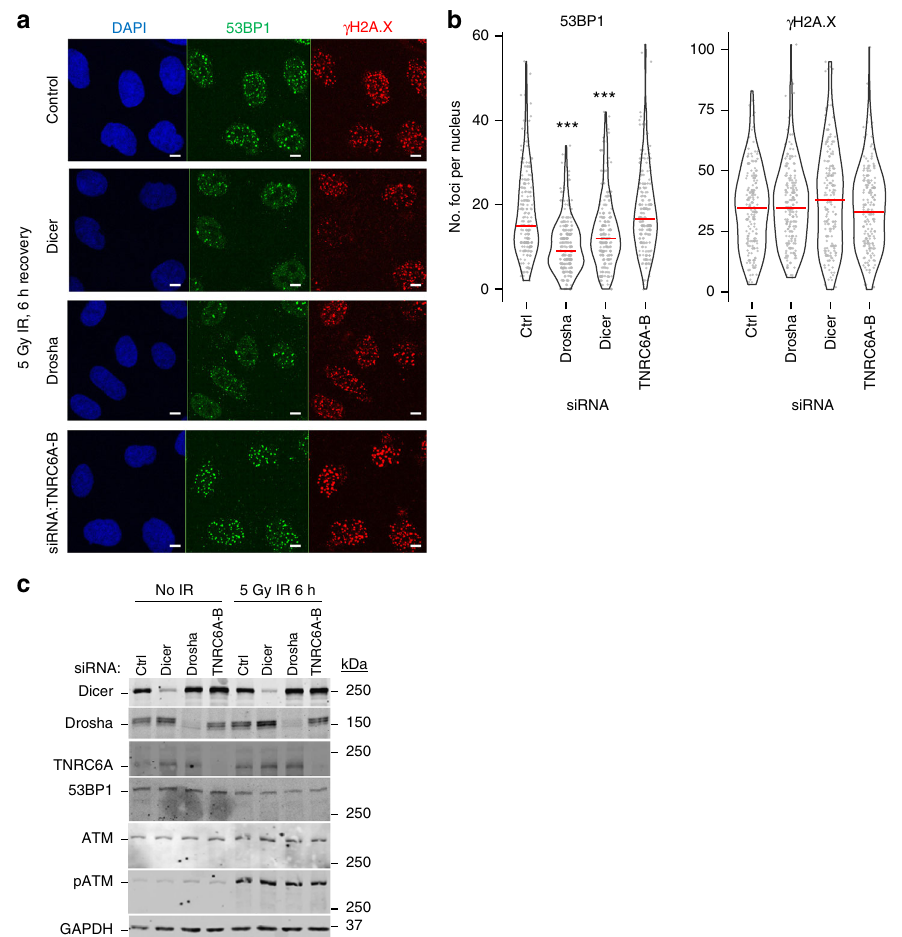
Fig. 1 Dicer and Drosha are required for formation of 53BP1 foci after ionizing radiation (IR). a Representative immuno fl uorescence images visualizing IR- induced 53BP1 foci in A549 cells. 53BP1 in green channel, γ H2A.X in red, DAPI-stained nuclei in blue. Scale bars, 10 µ m. b Quanti fi cation of a . The number of foci per nucleus was counted using the FindFoci ImageJ plugin and plotted as individual data points (gray) and a violin plot. Data from 3 biological replicates, counting at least 60 cells per replicate. Red line represents the median in each condition. Statistical testing was performed using Dunn ’ s test with Bonferroni correction for multiple comparisons, *** p ≤ 0.001. c Representative western blots for a , b con fi rming knockdowns and induction of